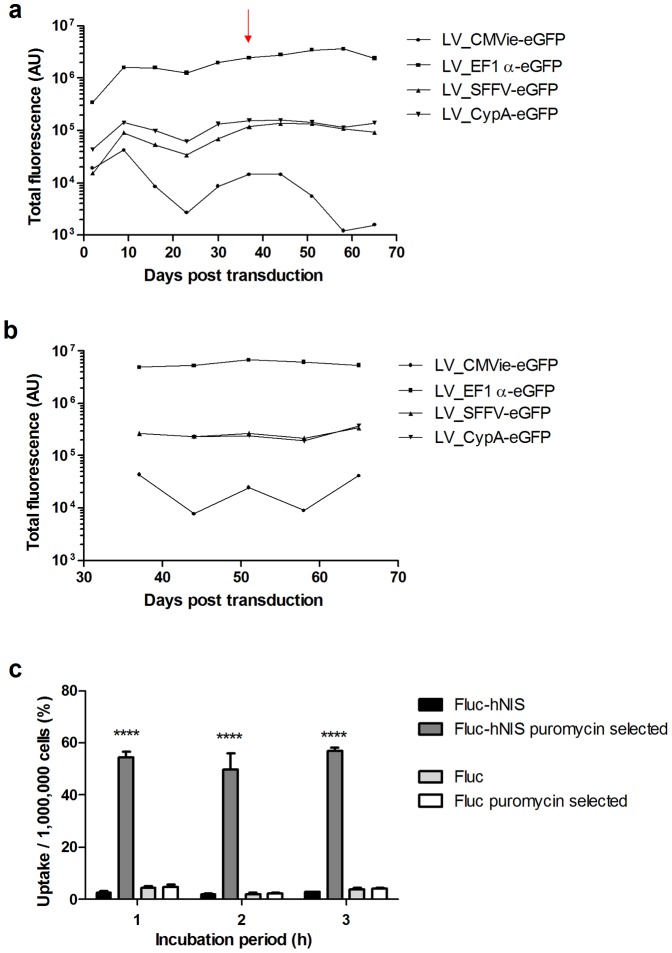
Optimization of LV constructs and selection.Different promoters were tested with FACS (AU: arbitrary units) for eGFP expression in MSCs transduced with different LV driven by different human or viral promoters (a). On day 38, FACS selection of the highest expressors was done (red arrow on panel (a)), and this population was also monitored (b). 99mTcO4
− uptake experiment in Fluc-hNIS or Fluc expressing MSCs with or without puromycin selection (c). ****:p<0.0001.